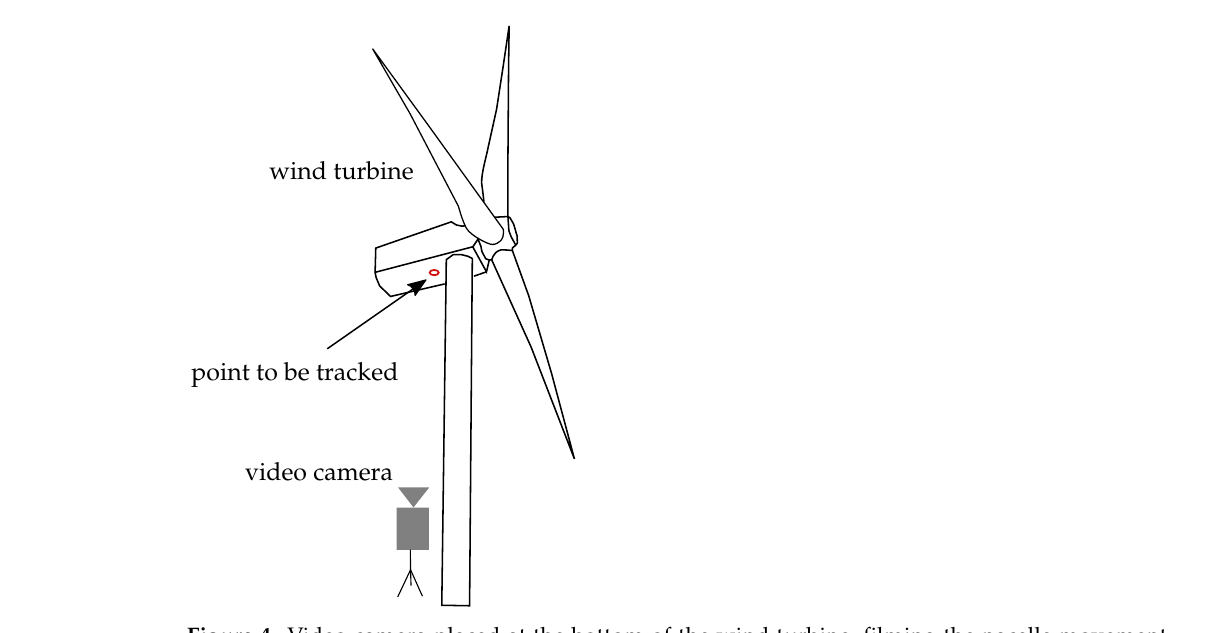
Figure 4. Video camera placed at the bottom of the wind turbine, filming the nacelle movement from below.